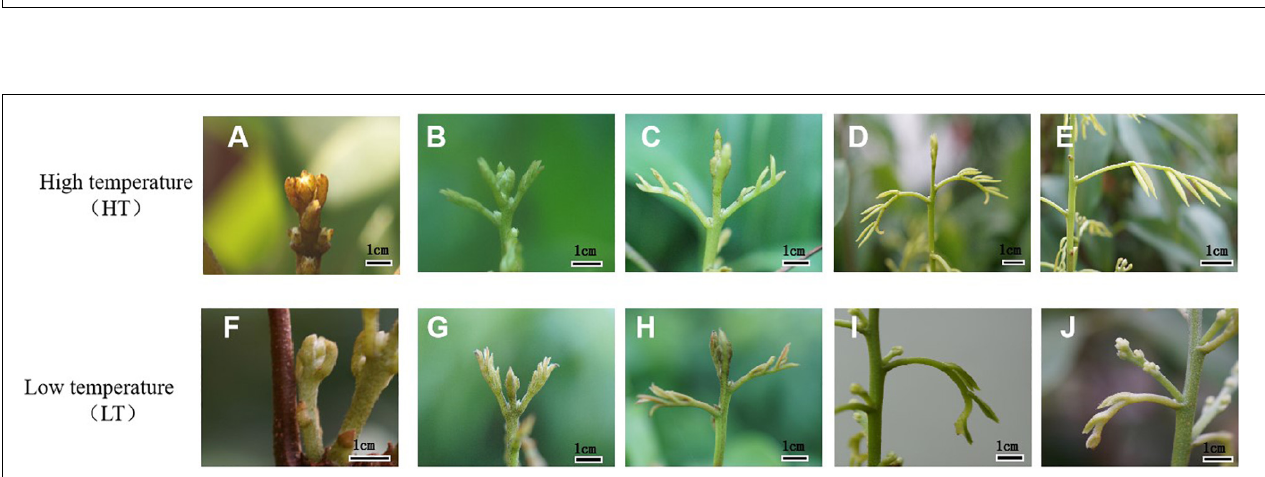
Frontiers in Plant Science |